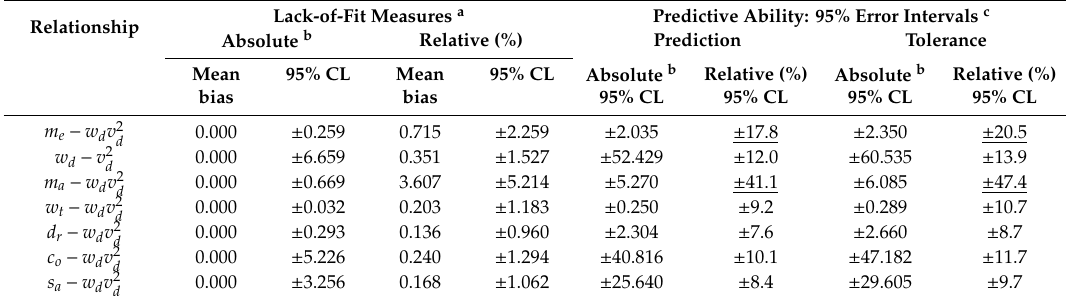
Lack-of-fit and predictive ability of the significant ( p ≤ 0.05) density-weighted and density-unweighted acoustic velocity-attribute relationships (Equations (5a) and